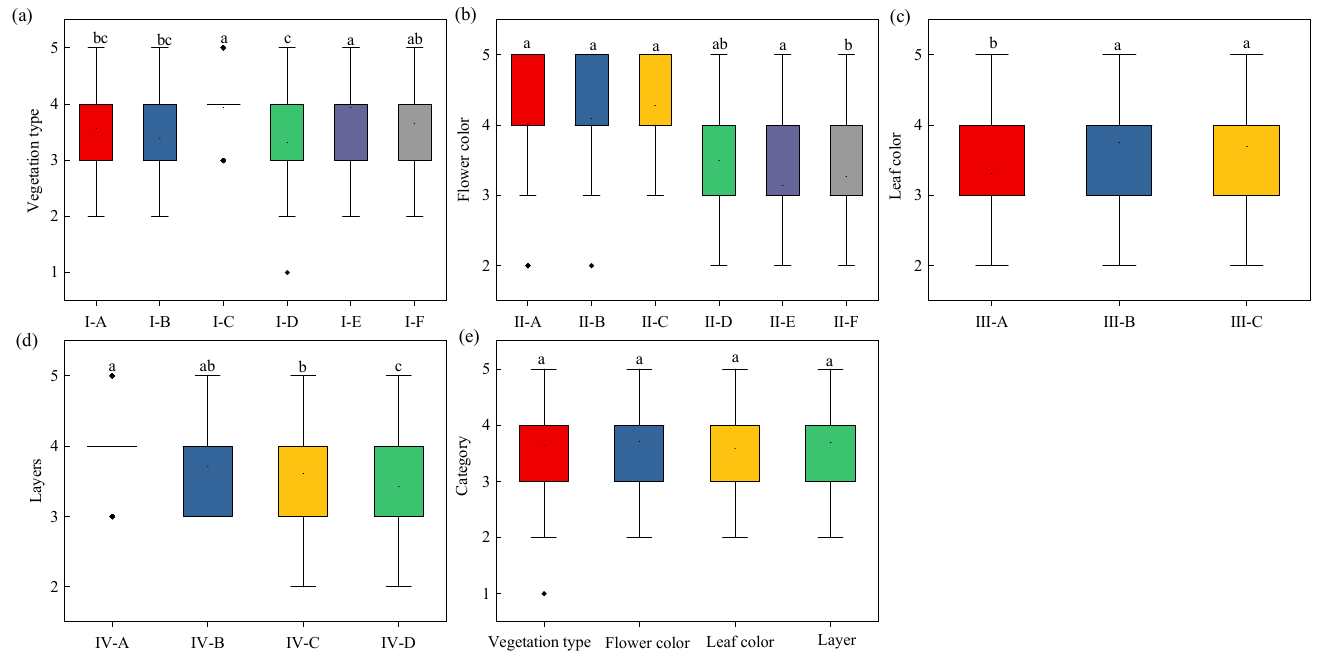
Figure 2. The subjective ratings of four categories in urban ornamental plants are shown; ( a – e ) represent vegetation type, flower color, leaf color, layers, and categories, respectively; I-A–I-F represent grassland, shrub, broad-leaf tree, coniferous tree, bamboo, and palm, respectively; II-A–II-F represent blue, red, pink, purple, white, and yellow flowers, respectively; III-A–III-C represent green, yellow, and red leaves, respectively; IV-A–IV-D represent tree + shrub + grass, shrub + grass, shrub, and grass, respectively. Different lowercase letters indicate significant differences among different attributes with the same category ( p < 0.05). Little square represents the mean and rhombus filled with black represents outliers.